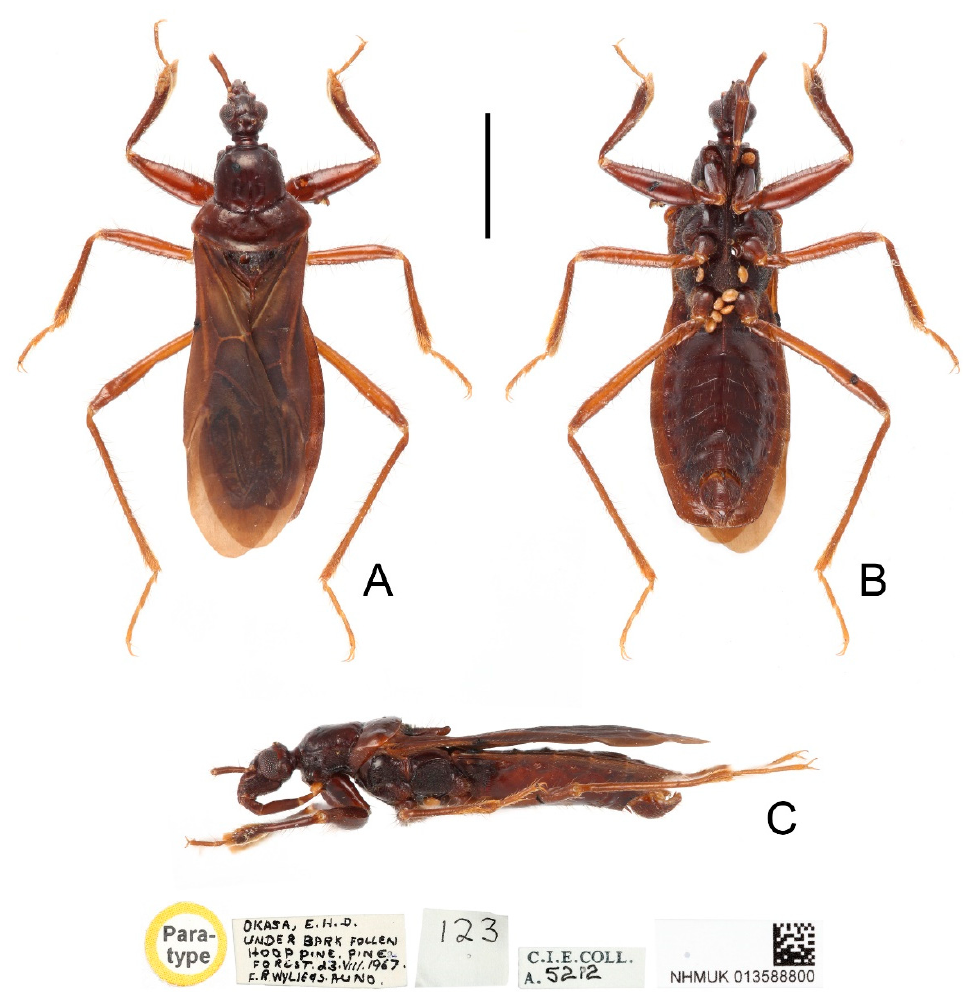
Figure 7. Sigicoris dominiqueae sp. nov. , paratype male, habitus. ( A ) Dorsal view. ( B ) Ventral view. ( C ) Lateral view. Scale bar = 3.00 mm.